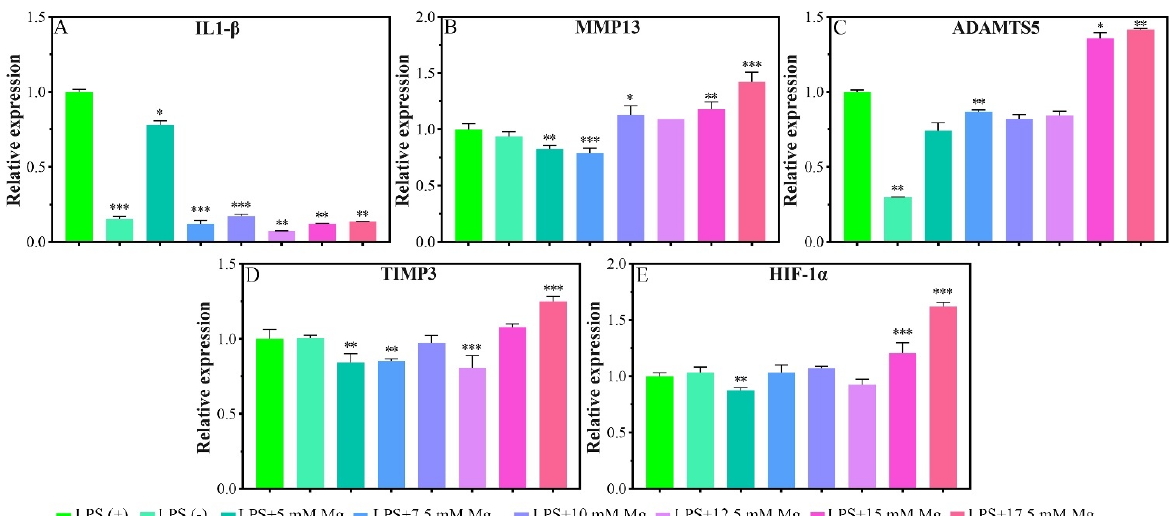
Figure 4. Inflammatory-related gene expressions of chondrocytes that cultured in different concentrations of Mg 2+ . All data are presented as fold change after normalization to GAPDH, and fold changes are shown as mean ± SD, * p < 0.05, ** p < 0.01, and *** p < 0.001.